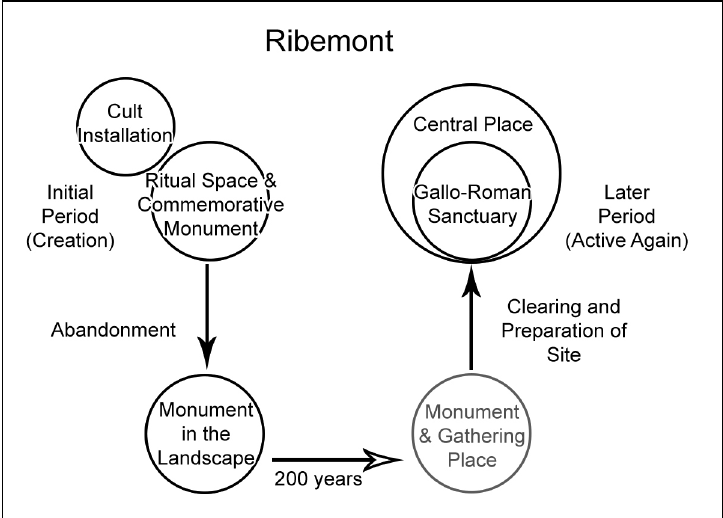
Figure 5: The theo- retical model applied to